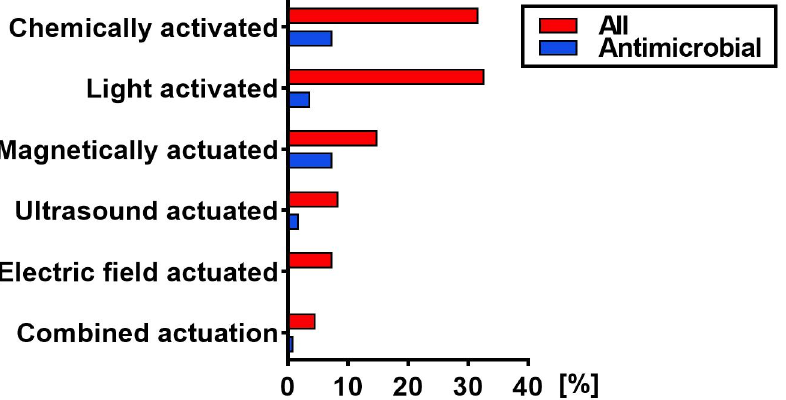
Figure 2. The percentile distribution of antimicrobial micro-/nanorobot articles regarding the driving mechanisms in comparison with all published articles in the last 5 years is given as a bar graph. The data are received from Web of Science and Scopus databases on 18 July 2022.